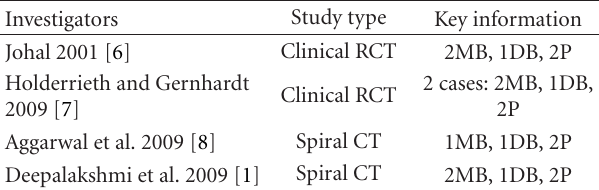
Figure 2: Length-determination radiograph. Table 1: Review of case reports of two palatal canals in one palatal root in maxillary first molar.